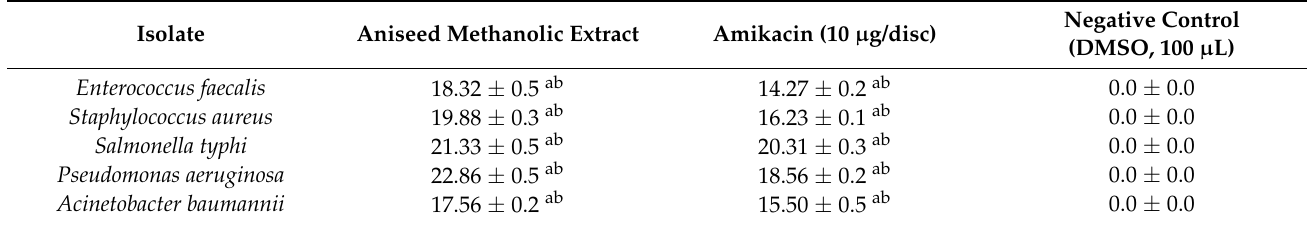
(Table 8). The selected isolates (Gram-negative: Salmonella typhi , Pseudomonas aeruginosa , and Acinetobacter baumannii ) and (Gram-positive: Enterococcus faecalis and Staphylococcus aureus ) were sensitive to aniseed extract based on the MIC and MBC assays. Table 7. Antimicrobial activity of aniseed methanolic extract against multidrug-resistant bacteria. Isolate